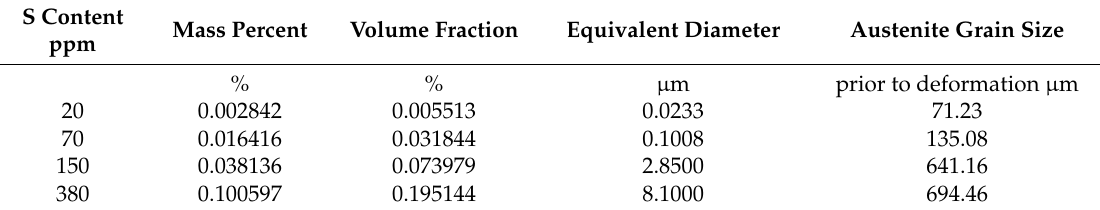
Table 6. Main parameters of MnS at 1150 ◦